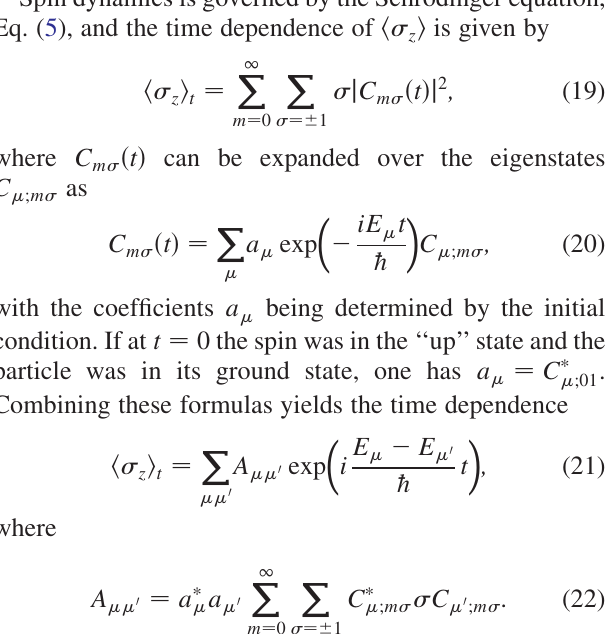
@ ! ¼ (cid:1) because of the resonance interaction between the spin and the resonator; see Eq. (18).